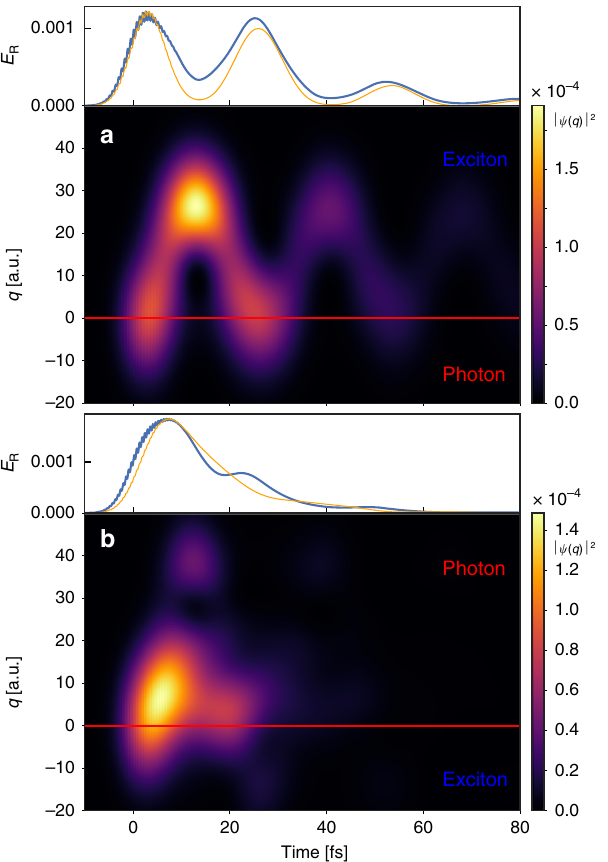
Fig. 3 Tracking nuclear dynamics using the time-dependent radiative emission. Probability density of the vibrational wavepackets in the single- excitation subspace for two different laser frequencies: ( a ) ω L = 3.3eV and ( b ) ω L = 3.7eV. The red line at q = 0 indicates the border where the polariton switches from photonic to excitonic character for the ( a ) lower and ( b ) upper polariton. The upper panels in each sub fi gure show the time- dependent emission from the cavity (thick blue lines) and the (scaled) probability of the nuclear wavepacket on the photonic side, given by q < 0 for a and q >0 for b (orange lines). For both calculations, E 0 = 2.1× 10 − 7 a.u. and σ L = 0.15 eV.